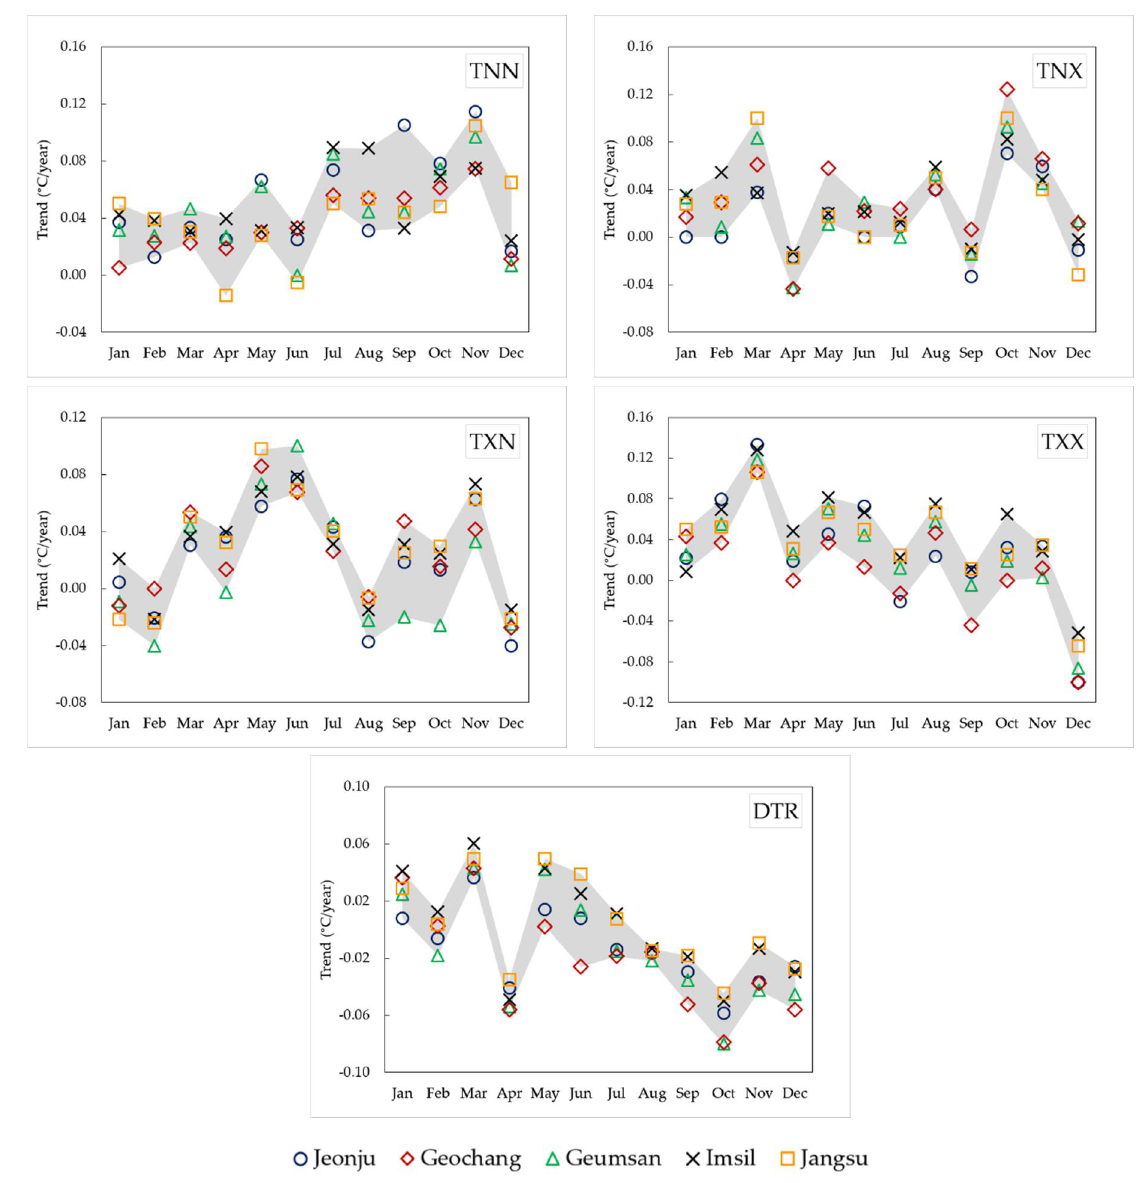
Figure 7. The monthly trend magnitudes of all temperature intensity indices at the